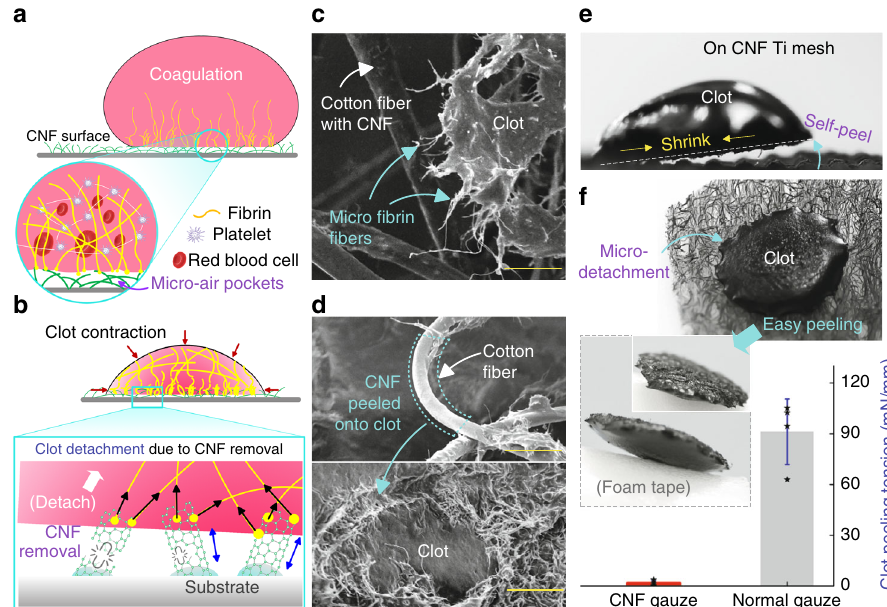
Fig. 4 Facile clot detachment. a Illustration of fi brin fi bers formation from blood on a superhydrophobic CNF surface. Due to its non-wetting property and the presence of micro-air pockets (Cassie – Baxter state 28,49 ), the CNF surface would only partially attach onto the clot. b During clot maturation, the fi brin mesh would squeeze out the serum and shrink the clot into a smaller size; 39 contractile stress during clot contraction and solidi fi cation would remove CNFs connected with micro- fi brin fi bers, causing the clot to free itself from the superhydrophobic CNF surface. c SEM image of the micro- fi brin fi bers adhered on the CNFs-coated cotton fi ber after clot shrinkage (Supplementary Fig. 12a, b). d SEM images show CNFs transferred onto clot after clot detachment, resulting in a smooth cotton fi ber, and a hairy clot surface (Supplementary Fig. 12c). e Clot self-peel from a stiff CNF Ti mesh surface (Supplementary Fig. 11d – f). f Facile clot detachment; clot formed on the CNF gauze can be easily picked off by a foam tape and the corresponding clot-peeling tension is about 54 times smaller than that for peeling a clot from the normal gauze ( n = 4, the setup in Supplementary Fig. 13); brie fl y, the gauze with a clot was mounted onto a force sensor, which was used to record the clot-peeling force for the calculation of peeling tension; data in f are shown as mean ± SD, the error bar represents SD, and individual data points are represented by black stars. Scale bars are 25 μ m in c and 50 μ m in d . Source data for f are provided as a Source Data fi